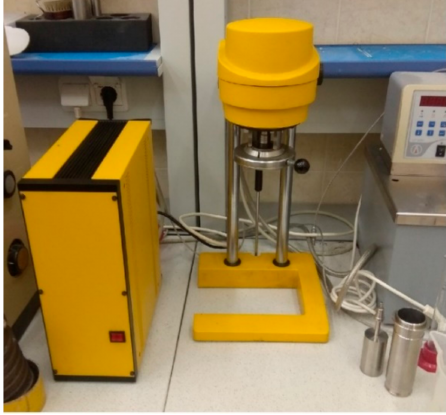
Figure 1. General view of the viscometer Rheotest RN